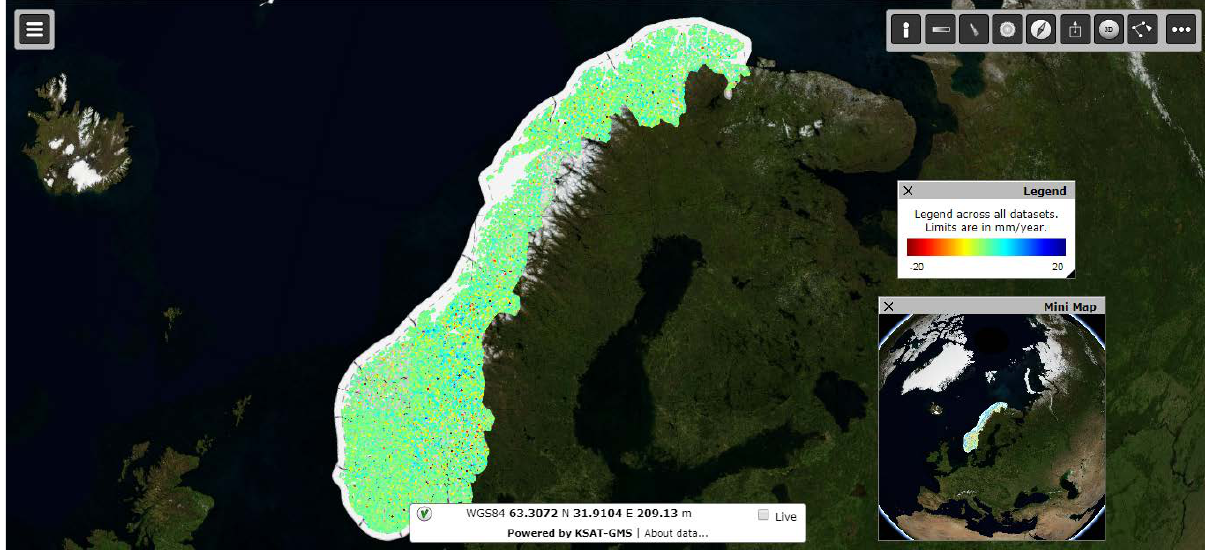
Figure 4: View of the geoportal of Norway -